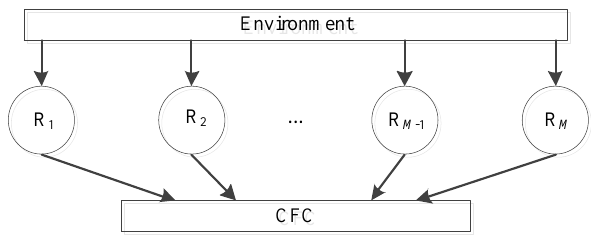
Figure 1. Centralized fusion architecture.